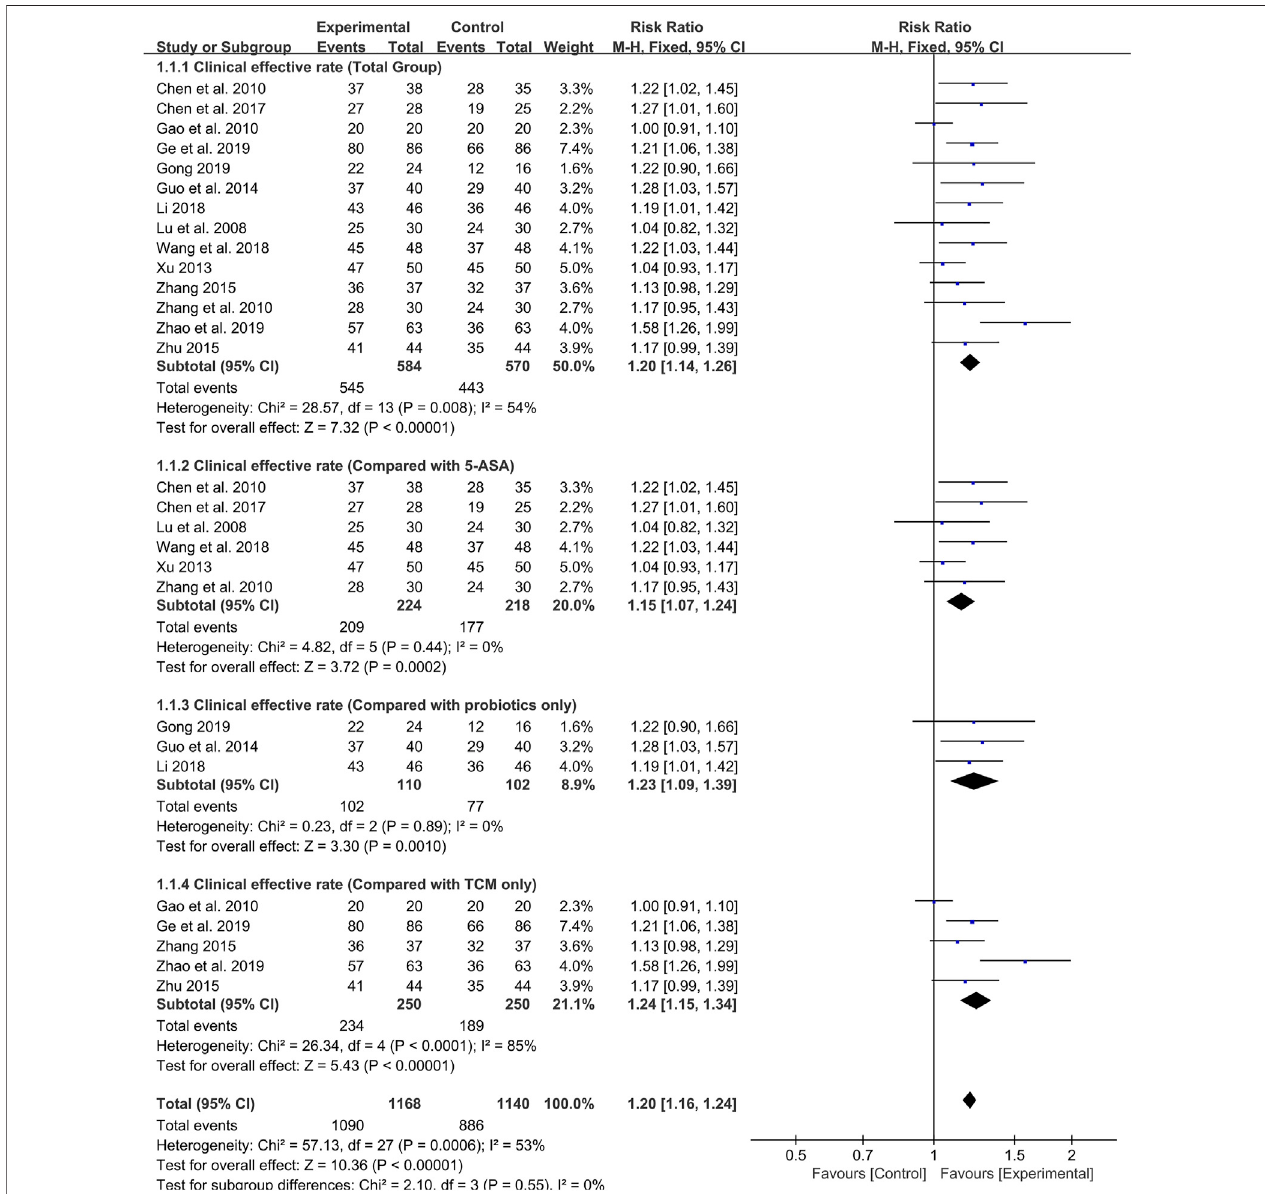
FIGURE 3 | Forest plot displaying the results of the meta-analysis for clinical effective rate in probiotics combined with TCM group vs. different controlled drugs group.